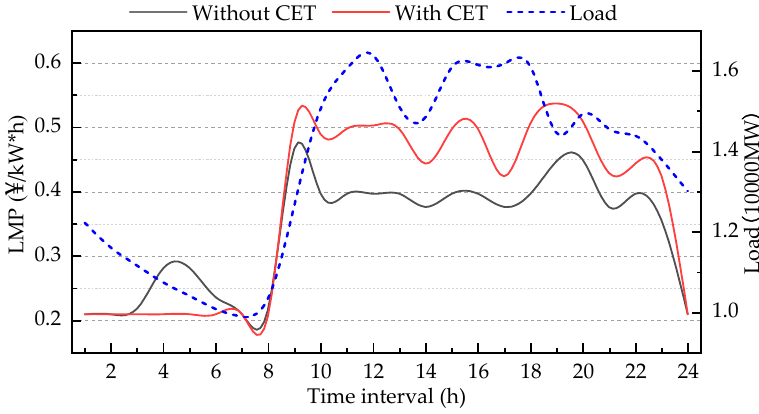
Figure 9. Comparison of the marginal price of the day-ahead market.